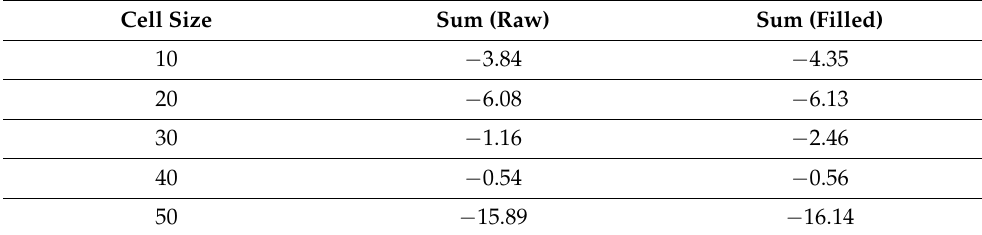
Table 3. Results of the sensitivity analysis (m 3